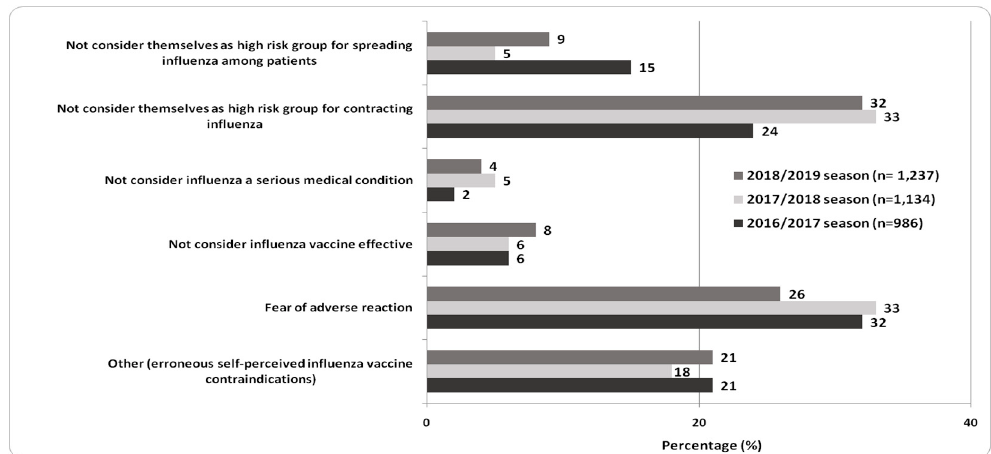
Figure 3. Reasons for not receiving influenza vaccination reported in the compulsory dissent form,